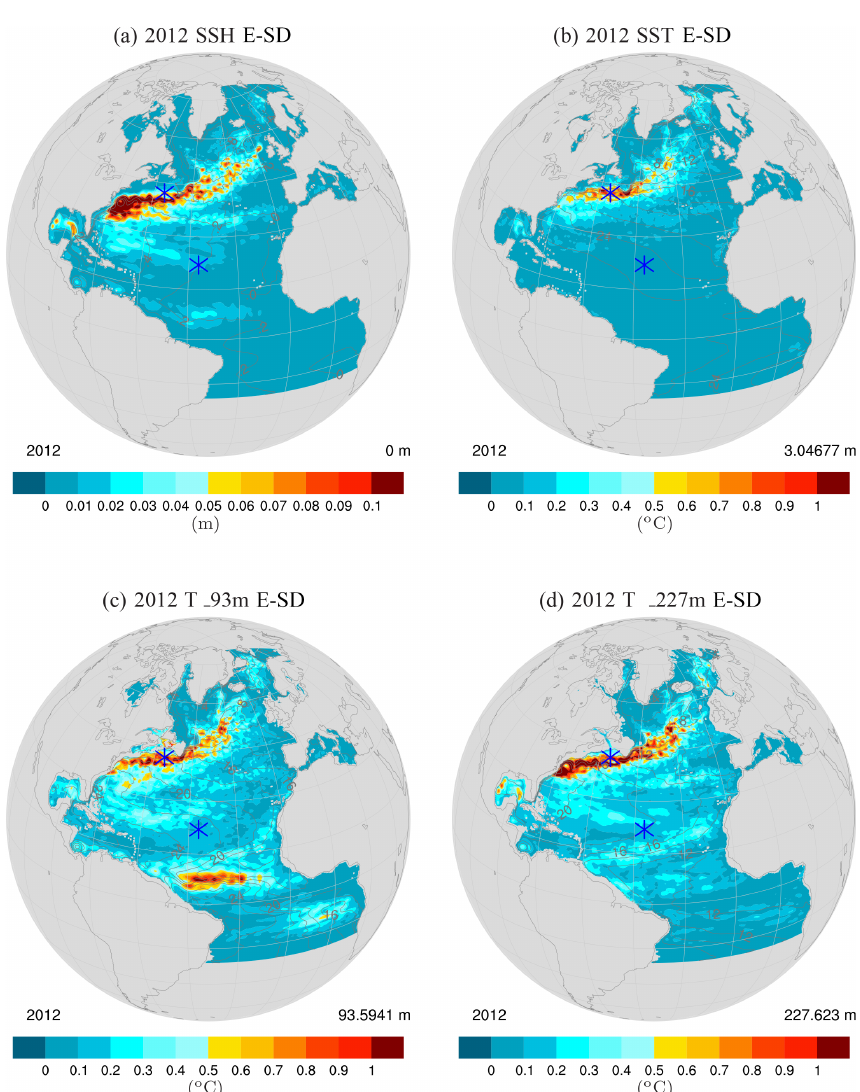
Figure 5. E-SD (shading) for year 2012 of the regional ensemble simulation E-NATL025, computed from annual means of (a) sea surface height (SSH), (b) sea surface temperature, and (c, d) temperature at depths 93 and 227m, respectively. The contours show the corresponding E-mean fields. The blue symbols pinpoint the two grid points at which time series are shown in Fig.